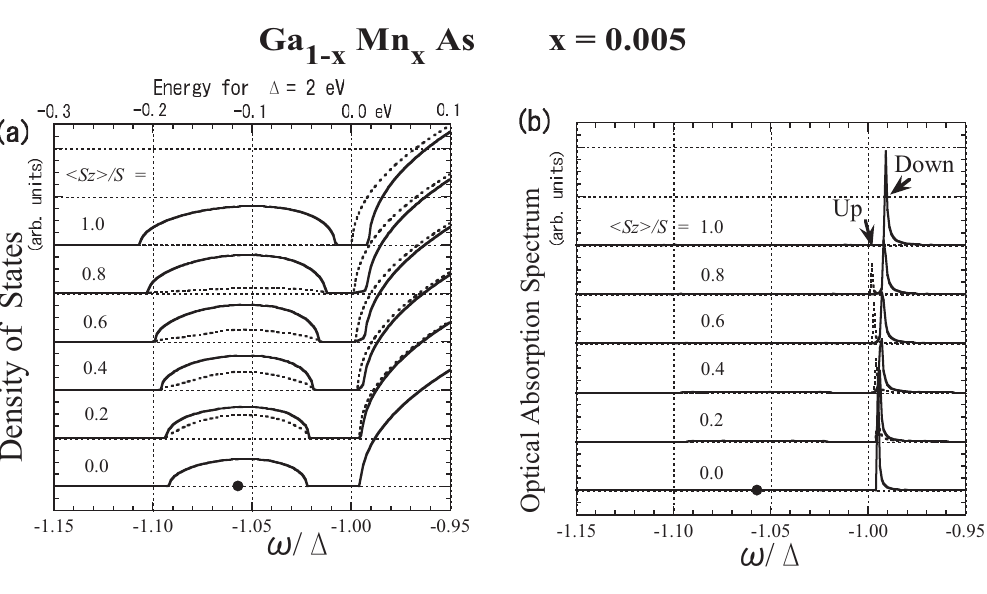
Figure 16. The result for Ga Mn As with x = 0 : 005 : (a) low-energy part of 1 − x x the DOS D ( ! ) , (b) optical absorption band A ( ! ) in arbitrary units (arb. units). The solid lines represent the down-spin carrier and the dotted lines represent the up-spin carrier. Note that the energy of the bottom of the model band is ! = − ∆ . Along the upper horizontal axis of (a), energies for ∆ = 2 eV are graduated in eV, where the origin of the energy, 0.0 eV, is taken at ! = − ∆ . The impurity = − 1 : 057∆ (or − 0 : 113 eV) is indicated by a dot on the line ⟨ S level E a From Takahashi [43]. Ga Mn As x = 1-x x